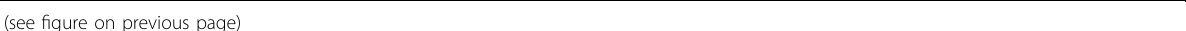
Fig. 7 DYRK1A inhibition reactivates the cell cycle in dormant RB-de fi cient cells. A Schematic overview of the experimental design. Dormant MMK1 cells were isolated by treating parental MMK1 cell population with 0.5 μ M of colchicine (Colch) for 14 days. Dormant cells were then cultured in drug-free medium (drug holidays, DH) or treated with DYRK1A inhibitor ALGERNON (ALG). Scale bar: 10 μ m. B Immunoblot analysis of DYRK1A (DYR) and retinoblastoma (RB) expression in parental and dormant MMK1 cells. Representative images of two independent experiments are shown. C , D RT-PCR analysis of cell cycle and dormant genes in dormant MMK1 cells. E Immuno fl uorescence images and quanti fi cation of Ki67-positive MMK1 cells. Dormant cells were treated ± ALG (1 μ M, 7 days), then stained to detect Ki67 (pink), tubulin (green) and DAPI (blue). Scale bar: 5 μ m. F Nuclear staining quanti fi cation of dormant MMK1 cells treated ± ALG (1 μ M) for 7 days. G RT-PCR analysis of cell cycle genes in MMK1 cells treated as outlined in panel ( E ). H Immunoblot analysis and densitometric quanti fi cation of cyclin B (Cyc B) expression in dormant MMK1 cells treated ± ALG